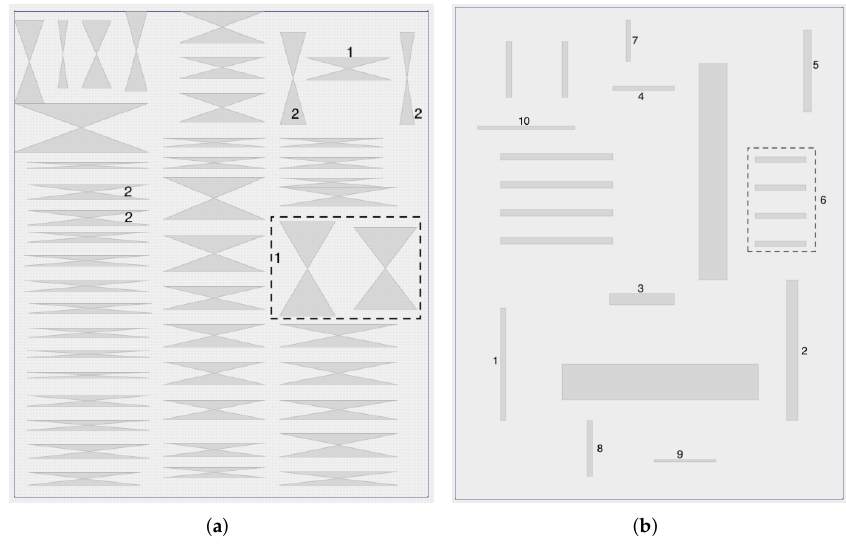
Figure 9. Updated floor plan of the simulation environments, with numbers indicating the order in which racks are added or modified. ( a ) Factory warehouse (112 m × 131 m). ( b ) Processing facility (138 m × 175 m).